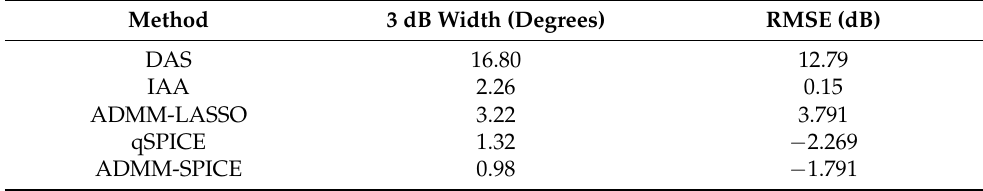
Figure 2. RMSE and CRB of each method. Table 2. Performance Comparison of Various Methods (SNR = 10